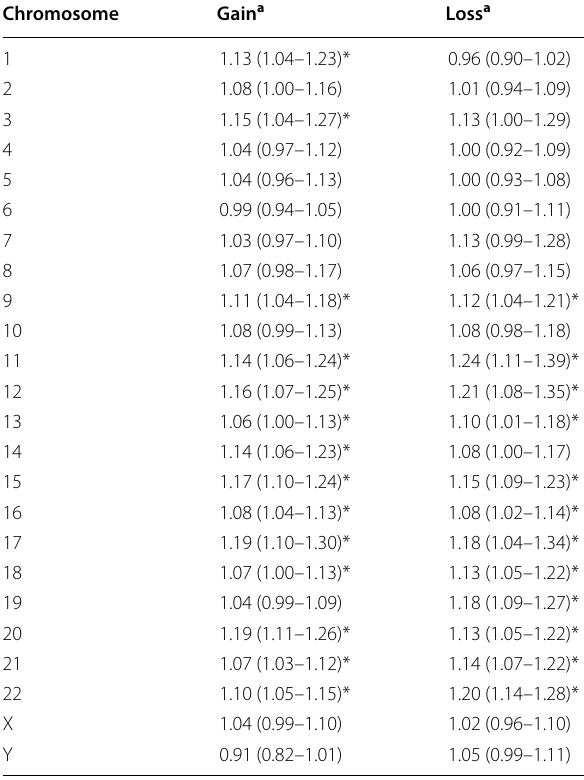
*Indicates a significant result (p < 0.05, two-tailed) a Values are odds ratios (OR) and 95% confidence intervals, which were calculated using multinominal logistic regression